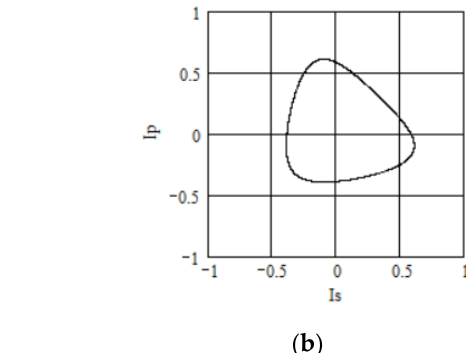
Figure 3. Orthogonal signal of polarized Fabry–Pérot interferometer. ( a ) Original signal; ( b ) signal with mean normalization processing.